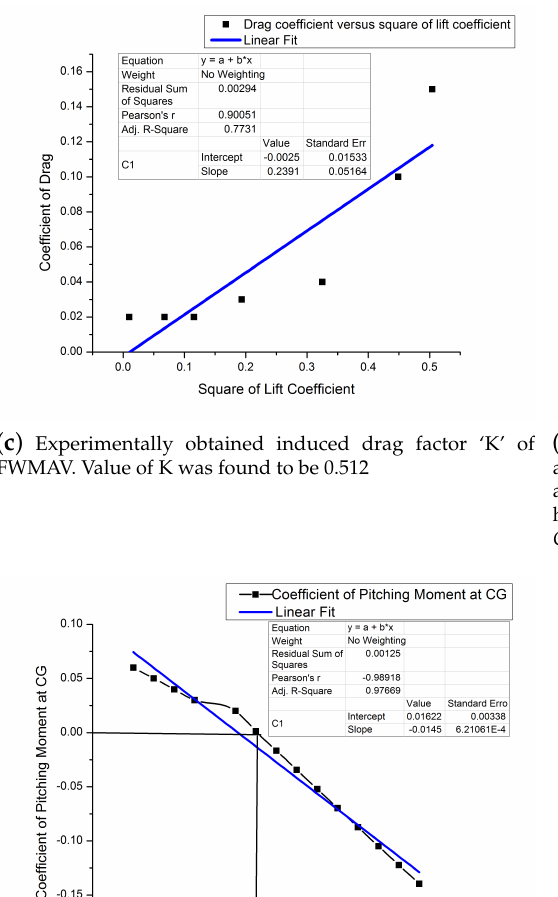
( a ) Experimental results of lift coefficient and lift to drag ratio ( b ) Drag polar obtained from wind tunnel tests. C variation with angle of attack. Graph shows C Lmax = 0.72, out ot be 0.015 = 17. α 0 L = − 0.3 ◦ , α stall = 7 ◦ and L D max